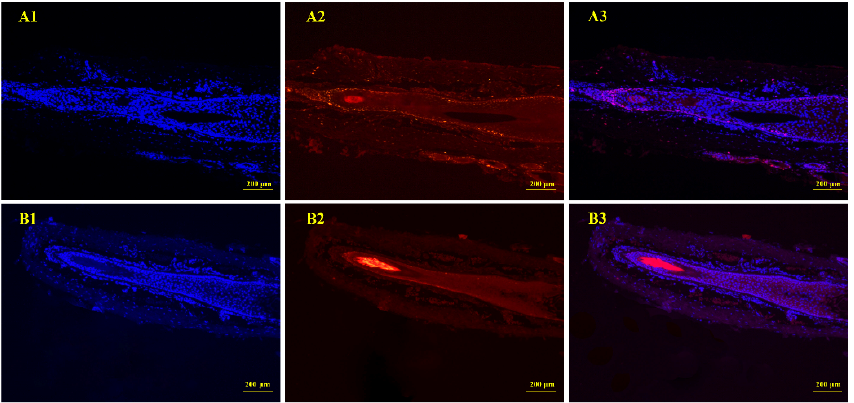
Figure 2. Hematoxylin–eosin (HE) staining of isolated hair follicles (HFs). ( A ) Control group ( B ) Combined treatment group. The black arrow points to the outer root sheath, and the yellow arrow labels the dermal papilla.